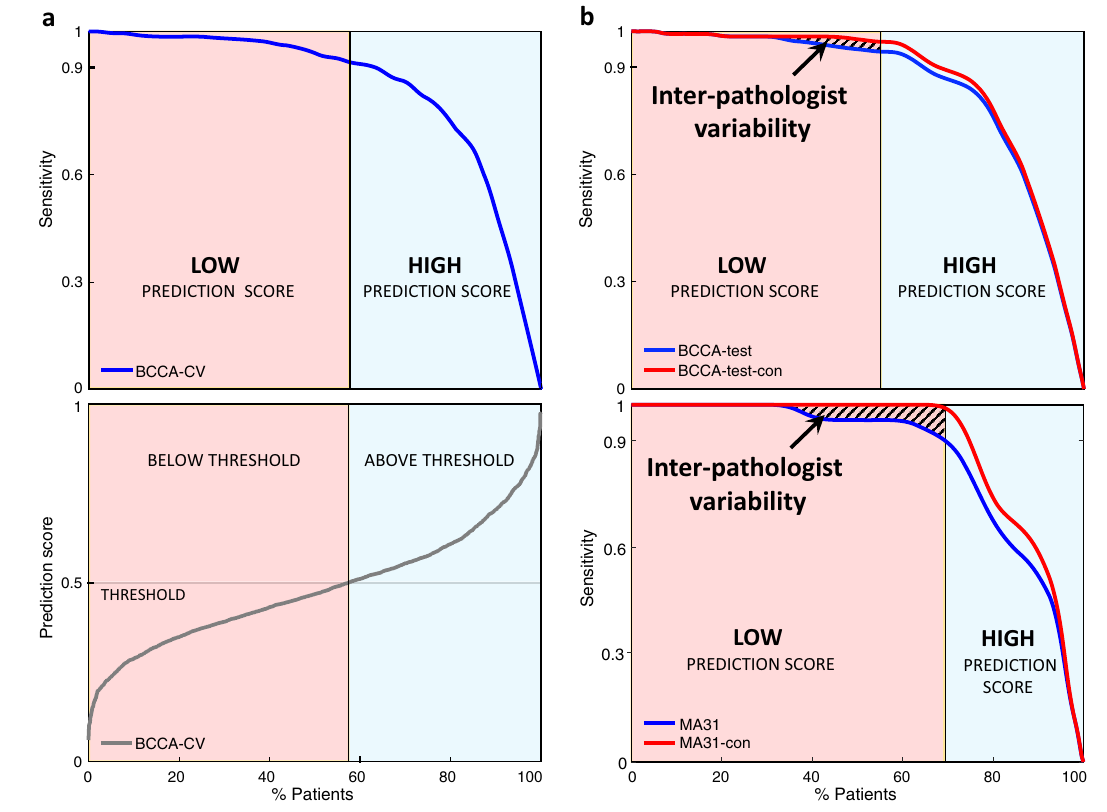
Fig. 3 | Impact of the proposed system on clinical practice. a The threshold for splittingthepatients ’ predictionscorestolowand highistunedintheBCCAcross- validation. Bottom: The sorted prediction scores of the patients, versus the per- centage of patients classi fi ed below the threshold. Top: The cross-validation sen- sitivity of the system, versus the percentage of patients classi fi ed below the threshold (i.e., classi fi ed as low-PS), showing a trade-off between the two. The thresholdwasselectedas0.5,resultinginasensitivityof0.92forBCCA-CVwith58% of the patientsinthe low-PSgroup. b Applying the selectedthresholdto the